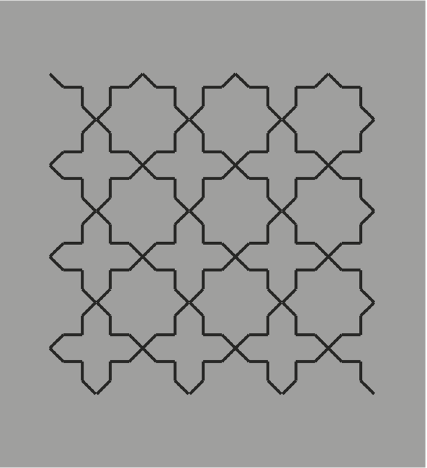
Figure 1. Crosses or stars? Alternated figure-ground segregation.